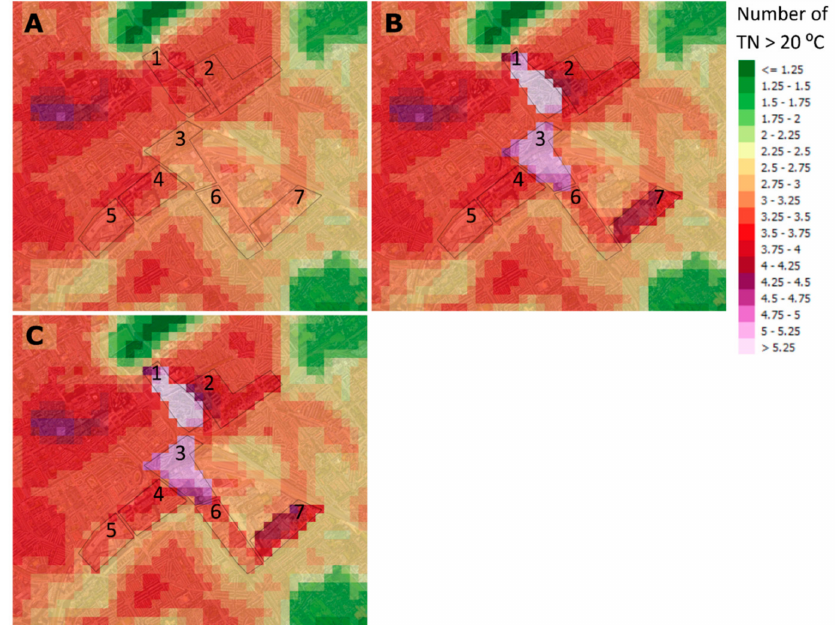
Figure 11. Difference in the modeled 95th percentile of the UHI max between strategy B and strategy C for the W H climate